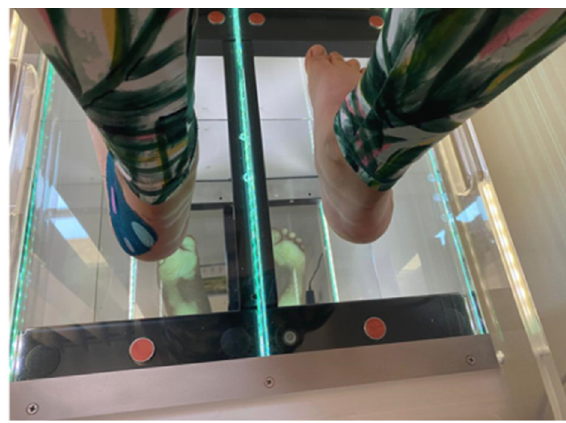
Figure 1. Patient preparation and positioning.